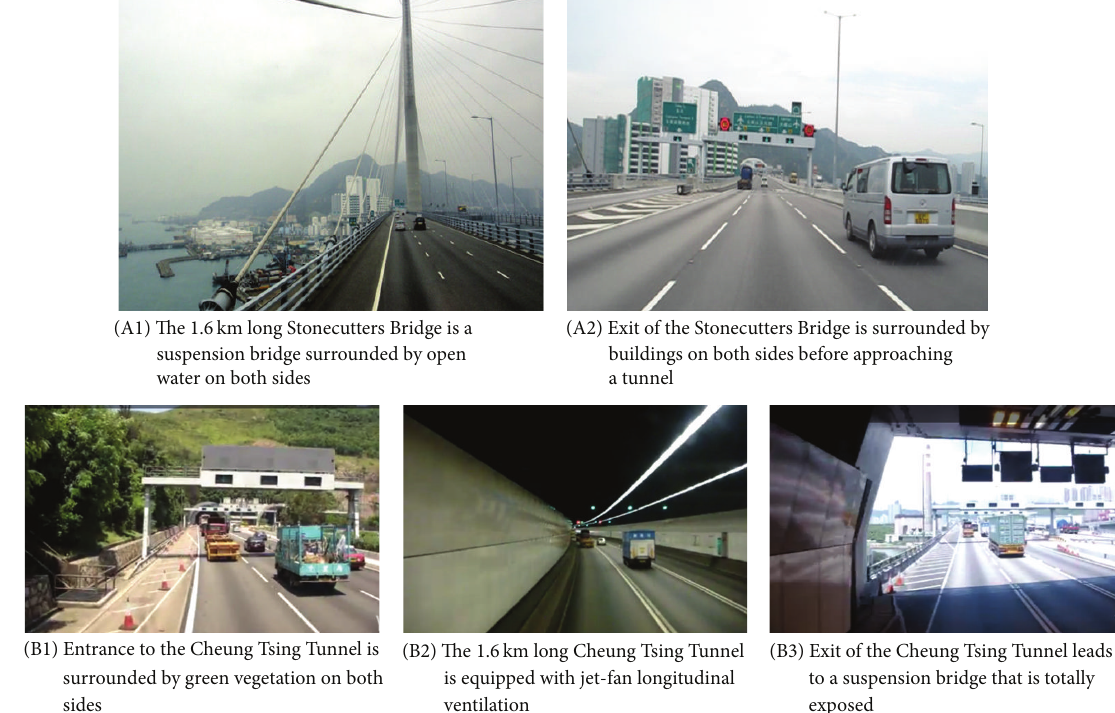
Figure 3: Photographs and descriptions of each of the sampling locations (A1, A2, B1, B2, and B3).